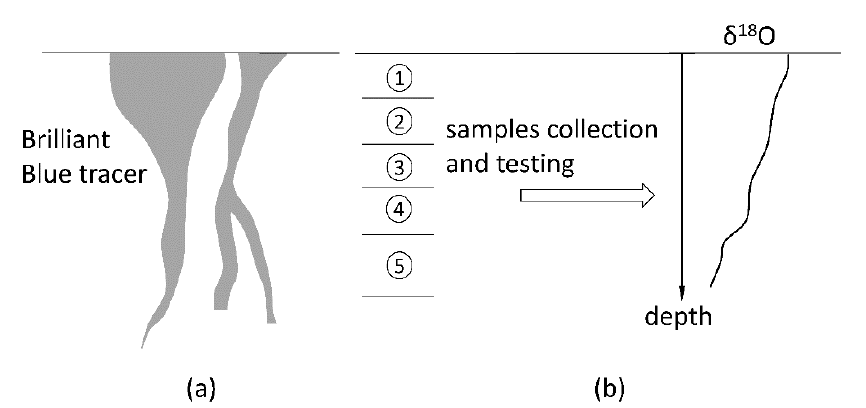
Figure 10. New experimental testing methods of preferential flow. ( a ) shows dye tracing method; ( b ) shows isotope tracing method.